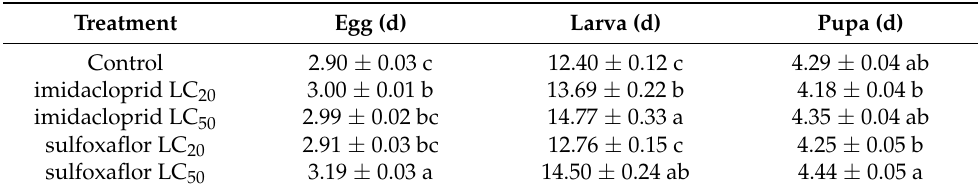
Table 5. Mean ( ± SE) values of stage-specific developmental duration of the progeny of Harmonia axyridis females exposed to imidacloprid and sulfoxaflor and their LC 50 and LC 20 estimated for the target pest, Aphis gossypii . Values followed by different letters, within the same column, indicate significant differences at p < 0.05